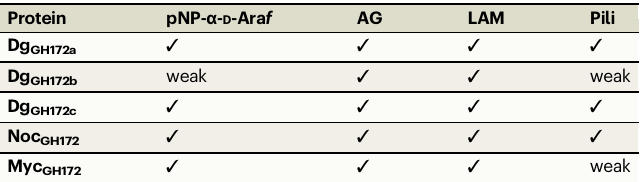
Table 1 | Activity of GH172 enzymes against synthetic and bacterial substrates Protein